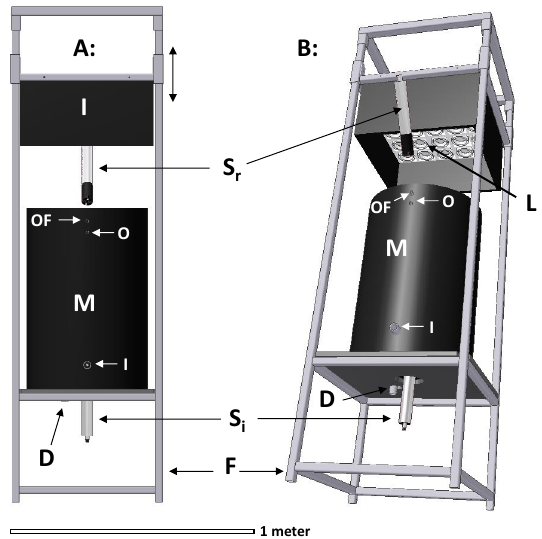
Figure 1. Schematic representation of the mesocosm system. A: side view; B: view from below. The mesocosm vessel (M, height 0.75m, diameter 0.50m) is placed inside a metal frame (F) that also holds the illumination box (I). The illumination box contains 25 Solux ™ lamps (L) and is height-adjustable. Two hyperspectral sensors were installed: one for bottom irradiance (S i ) and one for water-leaving radiance (S r ). Water was pumped round through an outlet at − 0.10m (O) and an inlet (I) at + 0.10m from the bottom. An overflow (OF) at − 0.05m was used to keep the water level con- stant. The mesocosm is emptied with a drain (D) in the bottom. For clarity, the construction holding the radiance sensor (S r ) and the electrical wiring, tubing, valves and pump are not